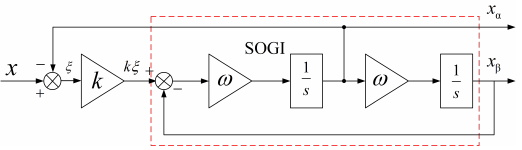
Fig. 7. Structure block diagram of SOGI-QSG